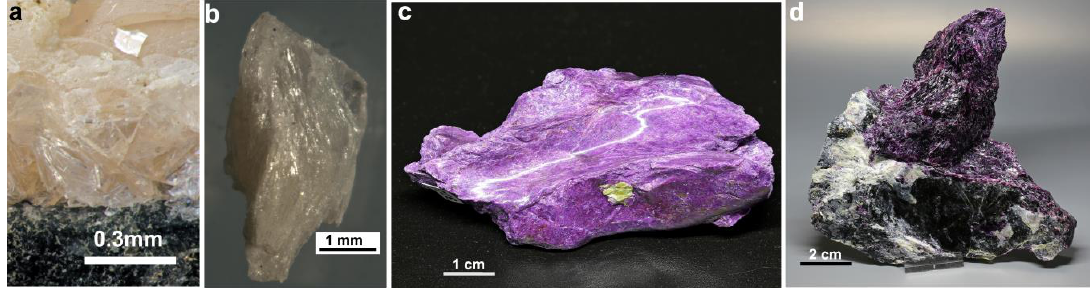
Figure 1. Photographs of minerals studied in this work: ( a ) quintinite, ( b ) hydrotalcite, ( c ) stichtite and ( d ) iowaite; c and d—collection and photo: V.V. Levitskiy.